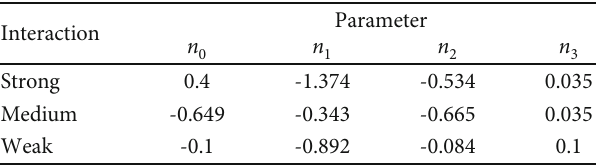
Table 3: Fluid noncontinuum property data for di ff erent fl uid- bearing surface interactions [24].